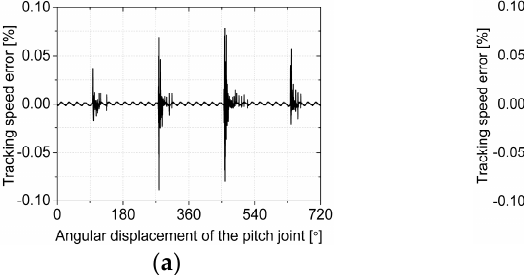
Figure 14. Radial runout of antenna reflector caused by different clearance size of planetary gear—the back solid line represents changing the clearance size in the azimuth joint; the blue dashed line represents changing the clearance size in the pitch joint; ( a ) c ip = 100 μ m, b isp = b irp = 100 μ m; ( b ) c ip = 100 μ m, b isp = b irp = 10 μ m; and ( c ) c ip = 10 μ m, b isp = b irp = 100 μ m ( i = p , a ).